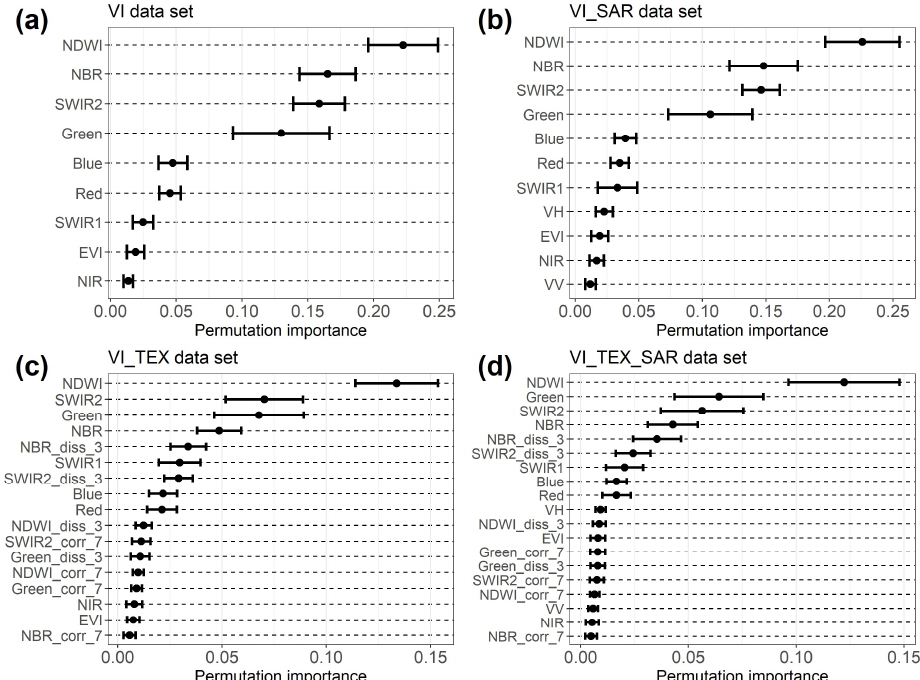
Figure 5. The permutation feature importance of the models constructed with the ( a ) VI, ( b ) VI_SAR, ( c ) VI_TEX, and ( d ) VI_TEX_SAR data sets. The permutation importance was calculated based on the overall classification accuracy difference between the original and permutated models. Dots represent the mean difference of 100 trials for each hyper-parameter-tuned model ( n = 16), and error bars represent the 95% confidence interval of the difference.